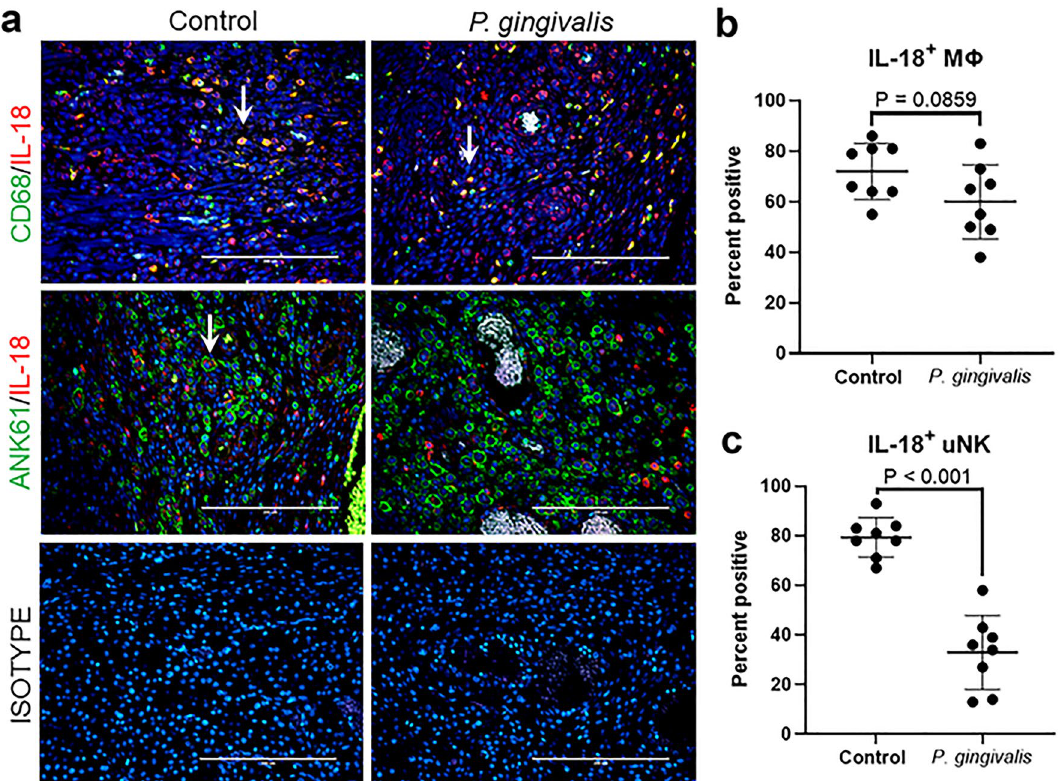
Figure 8. Impact of P. gingivalis infection on IL-18 (red) positive MΦ (CD68, green) and uNK cells (Ank61, green) in GD11 specimens. ( a ) Representative images of CD68+/IL-18+ MΦs or Ank61+/IL-18+ uNK cells taken with an EVOS Auto FL imaging system. White arrows indicate double positive cells. Scale bar = 200 µm. ( b ) Percent CD68+/IL-18+ MΦs. ( c ) Percent Ank61+/IL-18+ uNK cells. Horizontal lines in each graph indicate the mean ± SD. Data was analyzed by unpaired student’s t